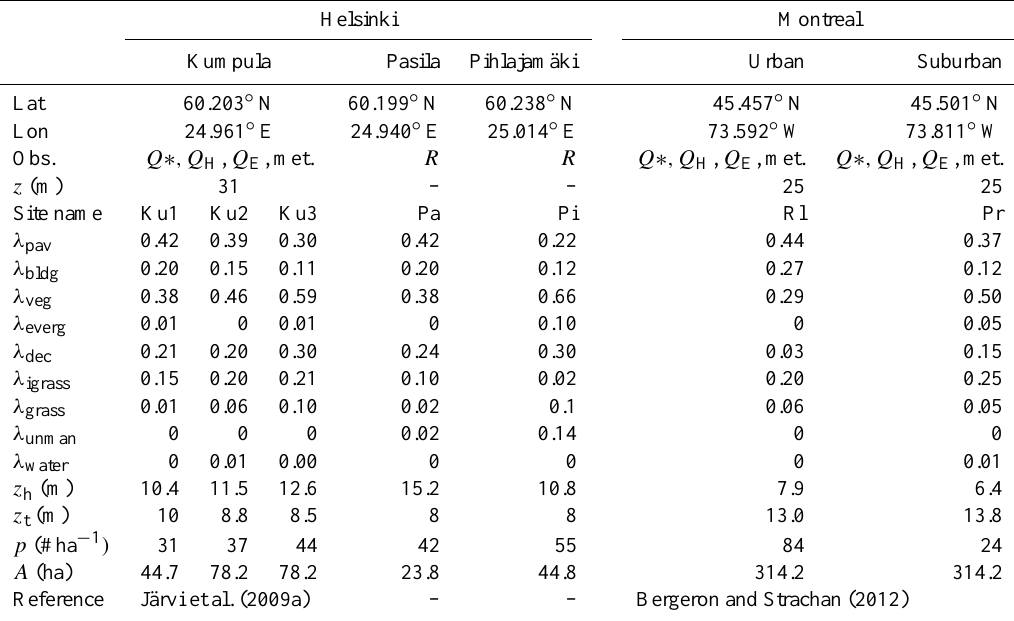
Table 1. Characteristics of the observational sites. Surface cover fractions for the eddy covariance (EC) sites are calculated for 1km radius circles, whereas the fractions of the catchments are for the actual catchment areas. In Kumpula, the area is divided into three surface cover areas (Ku1, Ku2 and Ku3). For the abbreviations see Appendix